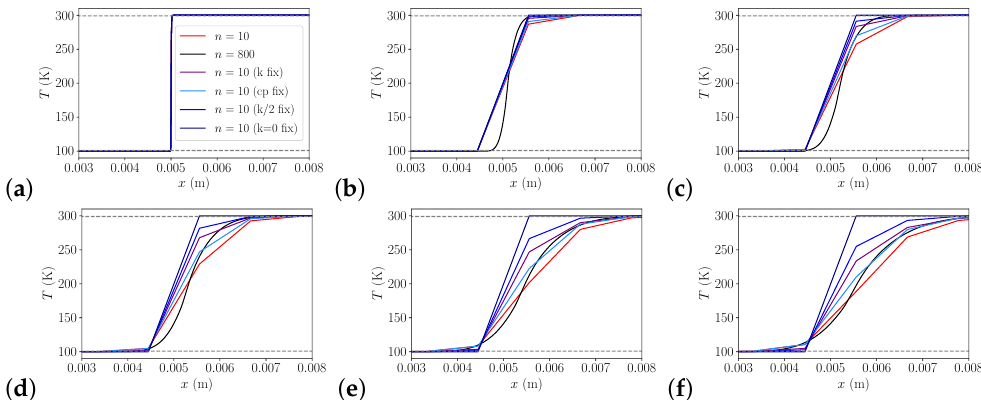
Figure 19. Plot of the temperature along the domain of the mesh at different time steps, ( a – f ) corre- sponding to t = 0,0.25,0.5,1,2,3 s. The red line is a simulation using ANN fluid property models { } on a coarse mesh of n = 10 elements, the light blue line is a case on a coarse mesh of n = 10 elements using ANN fluid property models but the isobaric heat capacity fix was applied, the purple line is a case on a coarse mesh of n = 10 elements but the thermal conductivity fix shown in Equation (3), the blue line is a case on a coarse mesh of n = 10 elements but the thermal conductivity fix shown in Equation (4), the dark blue line is a case on a coarse mesh of n = 10 elements but the thermal conductivity fix shown in Equation (5) and the black line is a case on a fine mesh of n = 800 elements using ANN fluid property